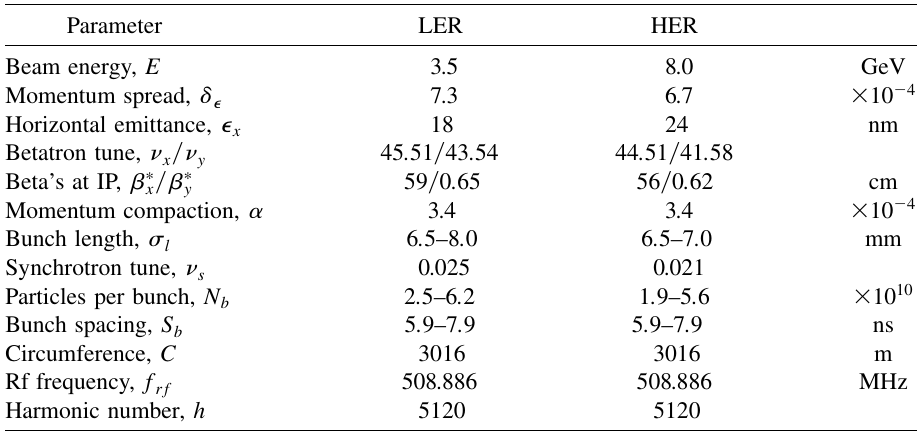
TABLE I. Machine parameters of